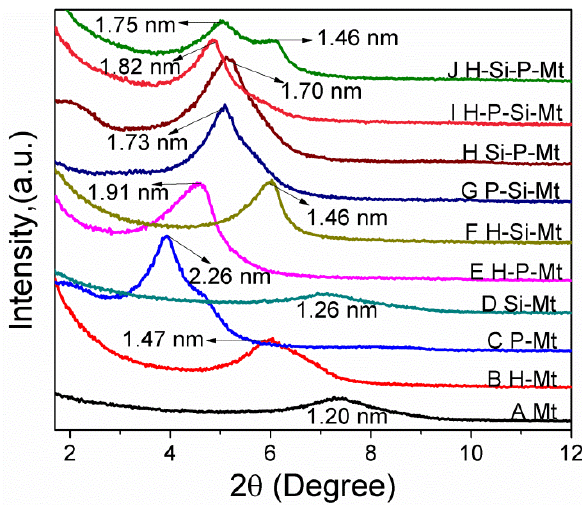
Figure 3. XRD patterns obtained from the Mt and functionalized Mt samples.